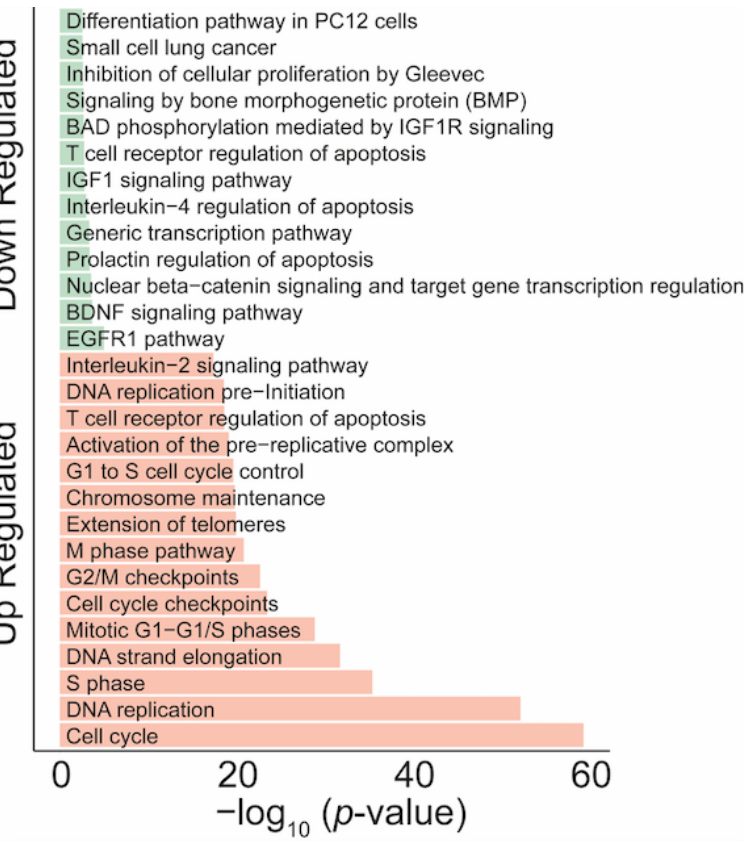
Figure 5. Functional annotation of enriched differentially expressed genes. The most relevant down-regulated pathways (green color) and up-regulated pathways (red color) pathways of genes potentially regulated by the AKNA transcription factor are shown (Enrichr database). An adjusted p value <0.05 is considered to be statistically significant.